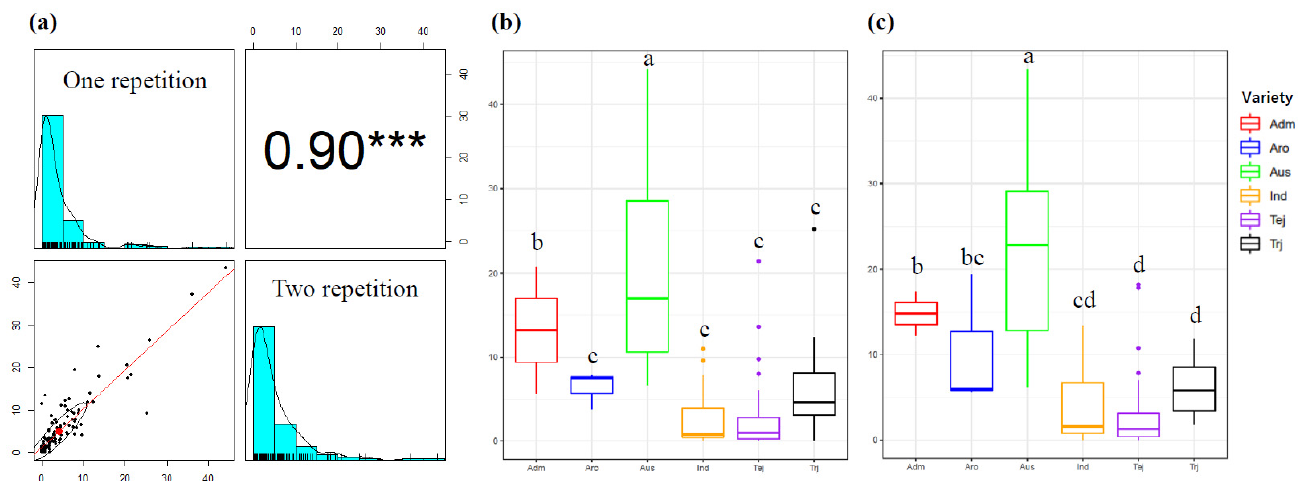
Figure 1. Statistical analysis of mesocotyl length (mm) in 137 rice varieties. ( a ) Summary of the phenotypic variations of mesocotyl length and correlations between one and two repetitions. Number in box is correlation coefficient (r), *** indicates the significance at p ≤ 0.001; ( b, c ) box plot of total mesocotyl length each repetitions according to subspecies. Adm: admixture , Aro: aromatic , Ind: indica , Tej: temperate japonica , Trj: tropical japonica . Letters: a, b, c, d represent different significance level at *** p < 0.001 (Duncan’s